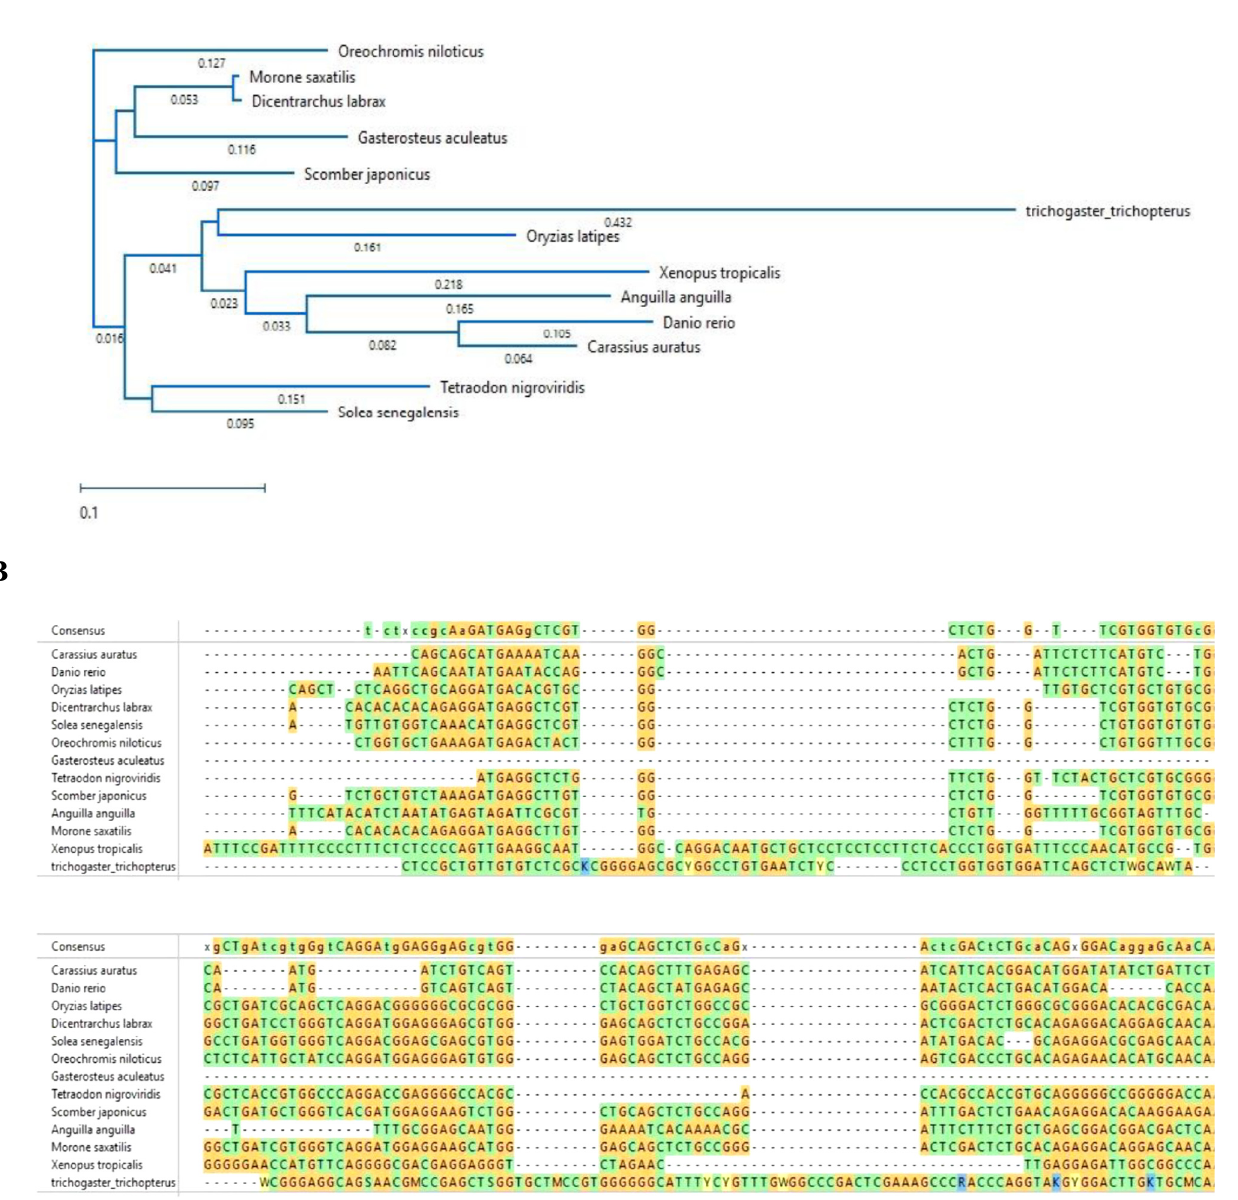
Figure 10. ( A ) : Phylogenetic tree showing the relationships between fish Kiss2 cDNA sequences. The tree was generated using MAFFT alignment in DNASTAR MegAlign PRO. ( B ) : Nucleotide and deduced amino-acid sequences [29]. There was a low degree of similarity for both nucleotide and amino acid se- quences of Kiss2 between the blue gourami and other fish species (Figure 10). A higher degree of similarity was found between the Kiss2r of blue gourami and those of the other fish species (Figure 11). The results show that Trichogster trichopterus Kiss2r’s amino acids sequence is very different from those of the species Tetraodon nigroviridis , Xenopus tropicalis , Scomber japonicus , and Gasterosteus aculeatus and closer to the species Danio rerio , Carassius auratus , and Dicentrarchus labrax .